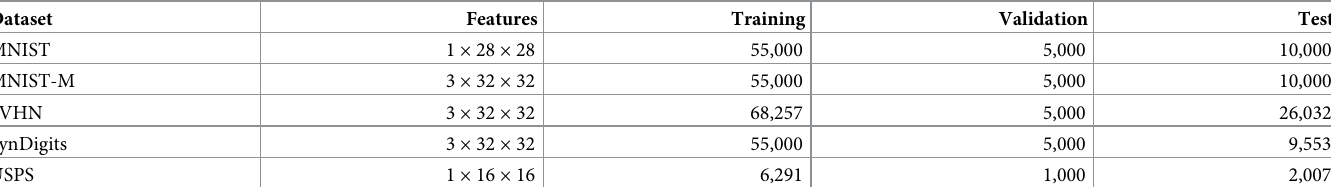
Table 4. Summary of datasets.